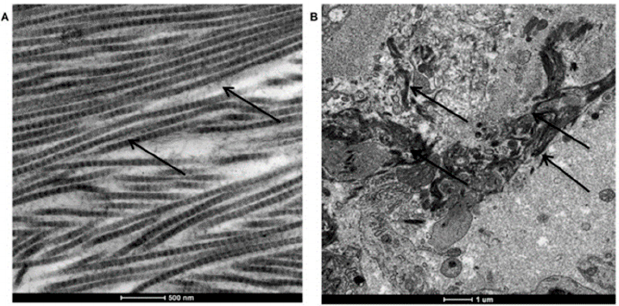
Figure 6. TEM analysis of collagen fiber disposition in peri-implant tissues. ( A ) Long and well- organized collagen fibers in healthy tissue. ( B ) Degraded and not organized collagen fibers in peri-implantitis affected tissue.